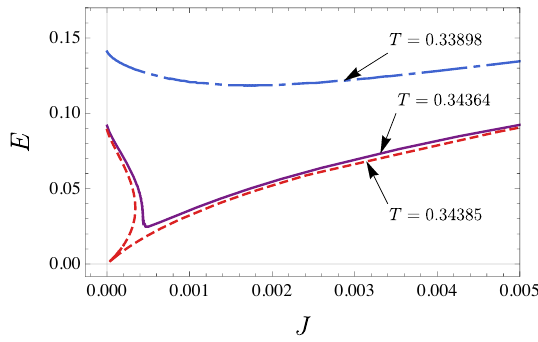
Figure 1 . J - E characteristics at various temperatures: from top to bottom T = 0 . 33898 , 0 . 34364 , 0 . 34385 respectively. We have set m q = 1 for